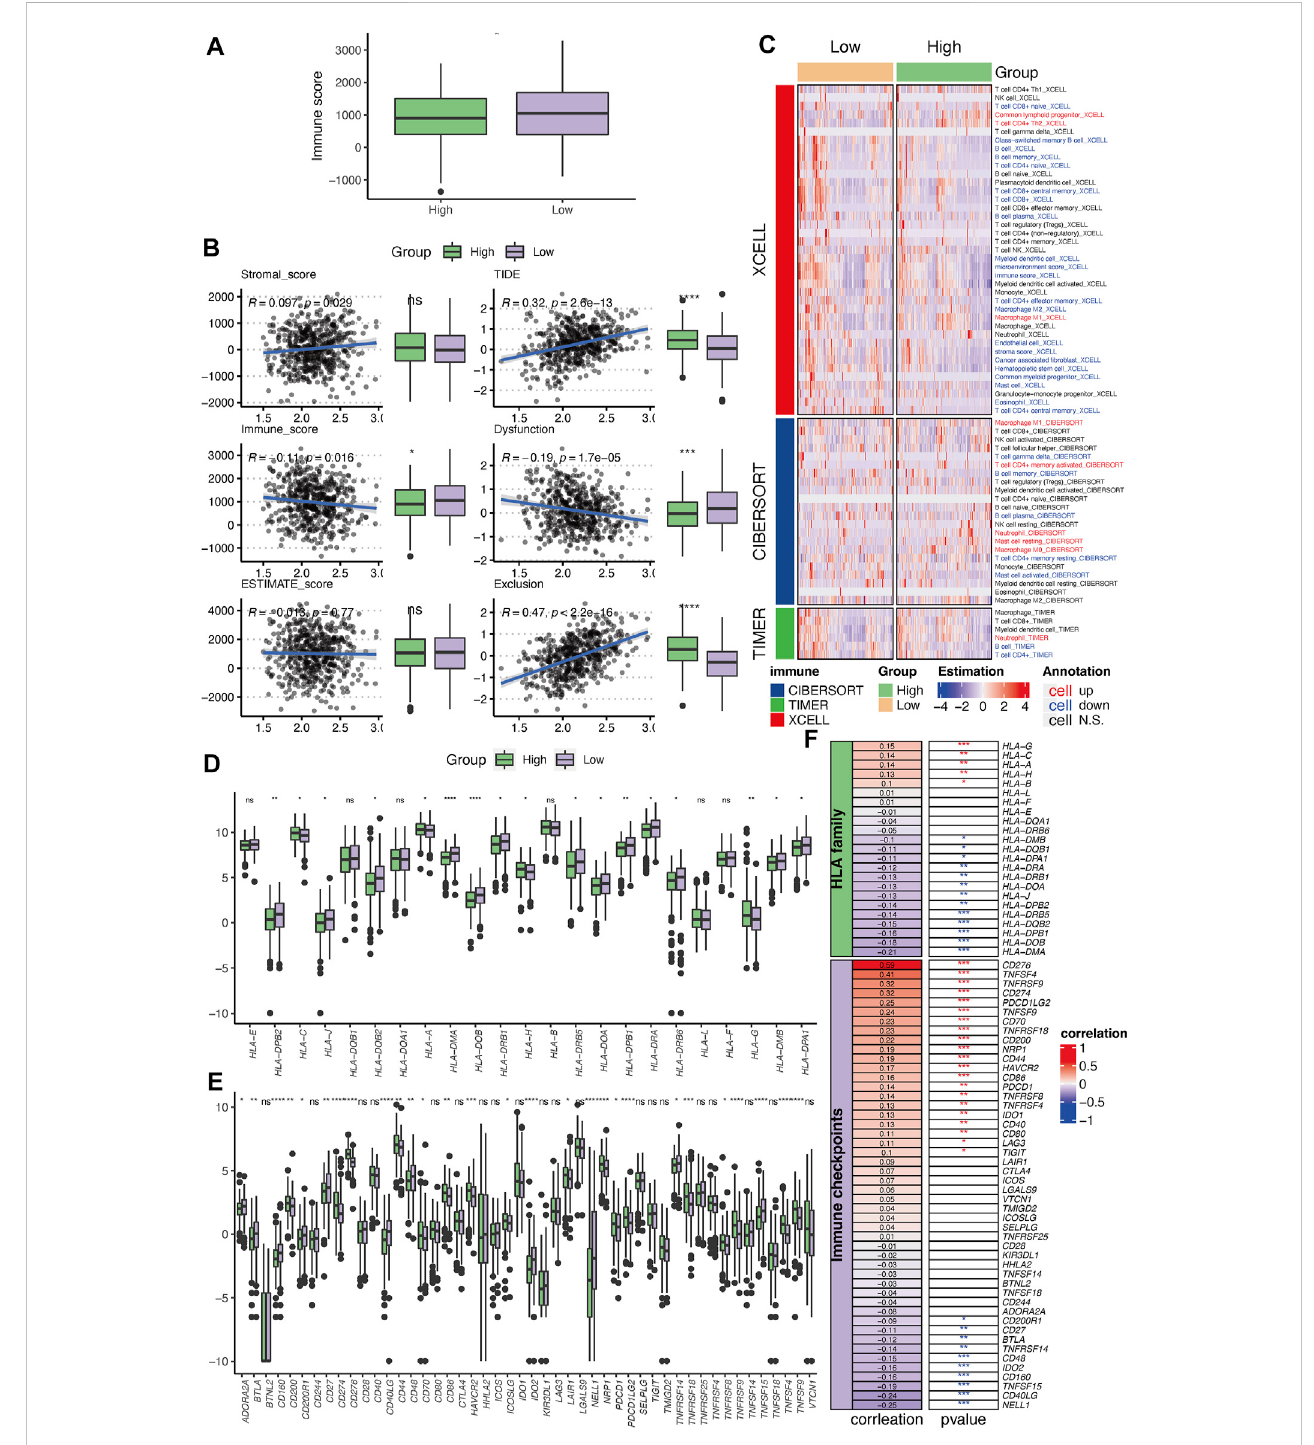
FIGURE 9 Immune pro fi le correlating with the established PSMC gene-based prognostic signature. (A) Differences in the immune, stromal, and ESTIMATE scores between the high- and low-risk groups. (B) Correlation between PSMC risk and TIDE scores. (C) Tumor-in fi ltrated lymphocyte pro fi le analyzed using XCELL, CIBERSOFT, and TIMER. (D) Differences in the expression levels of HLA family genes between the high- and low-risk groups. (E) Differencesin the expression levels of immune checkpoint genes between the high- and low-risk groups. (F) Correlation between the PSMC risk score and the expression of HLA family genes or immune checkpoints. * p < .05, ** p < .01, *** p < .001, and **** p < .0001; ns: not statistically signi fi